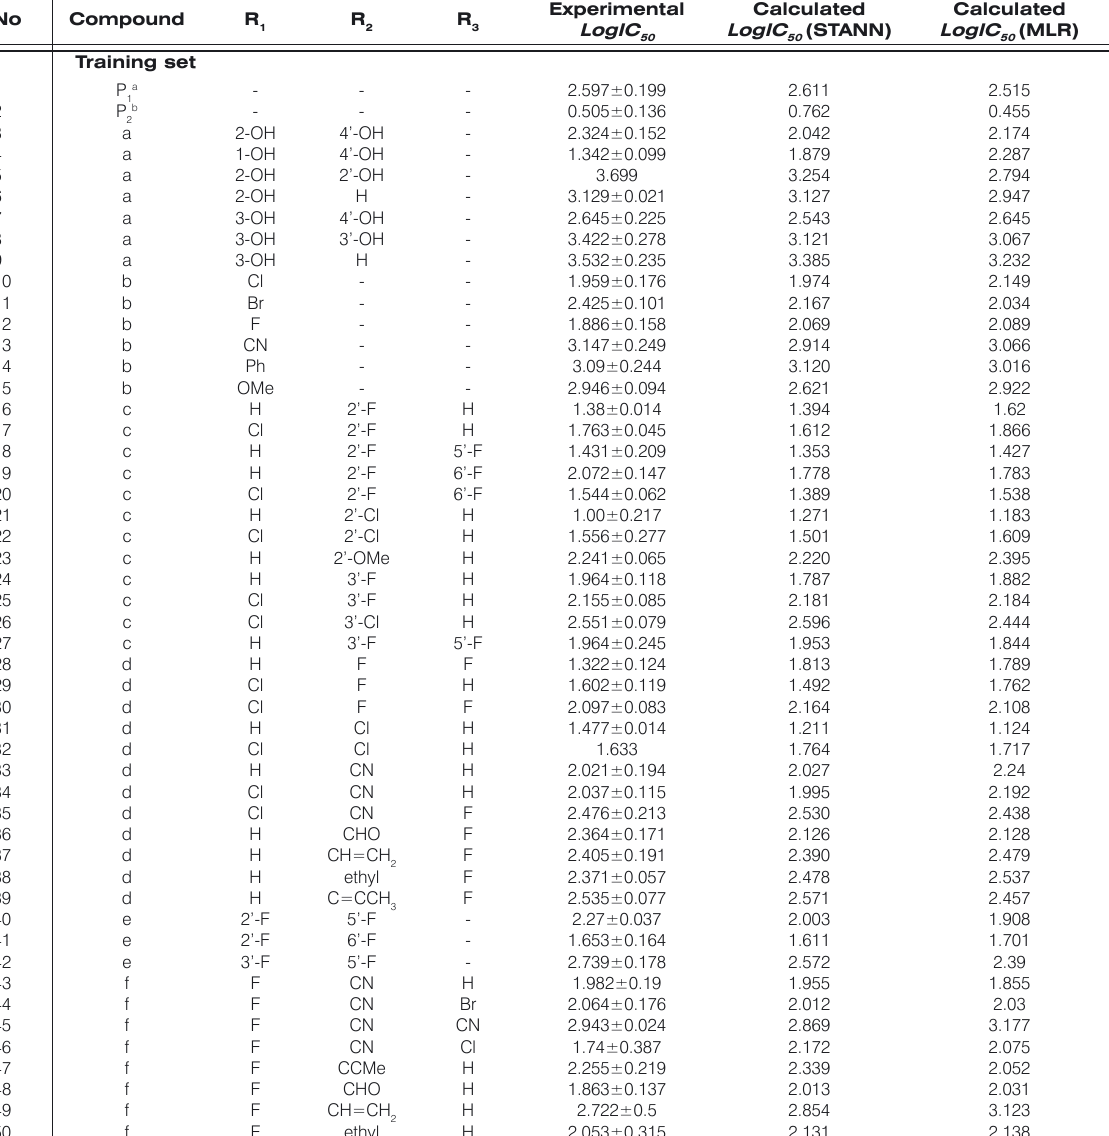
for the 2-phenylnaphthalene inhibitor 50